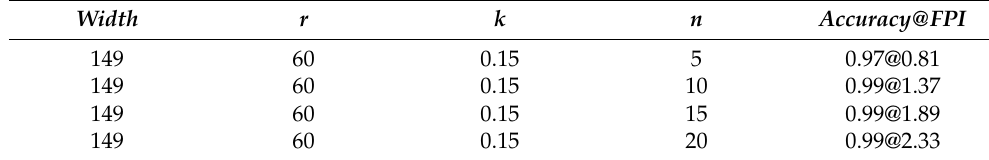
Table 11. Performance of the proposed GFNet framework on INbreast with false positive reduction but without NMS.